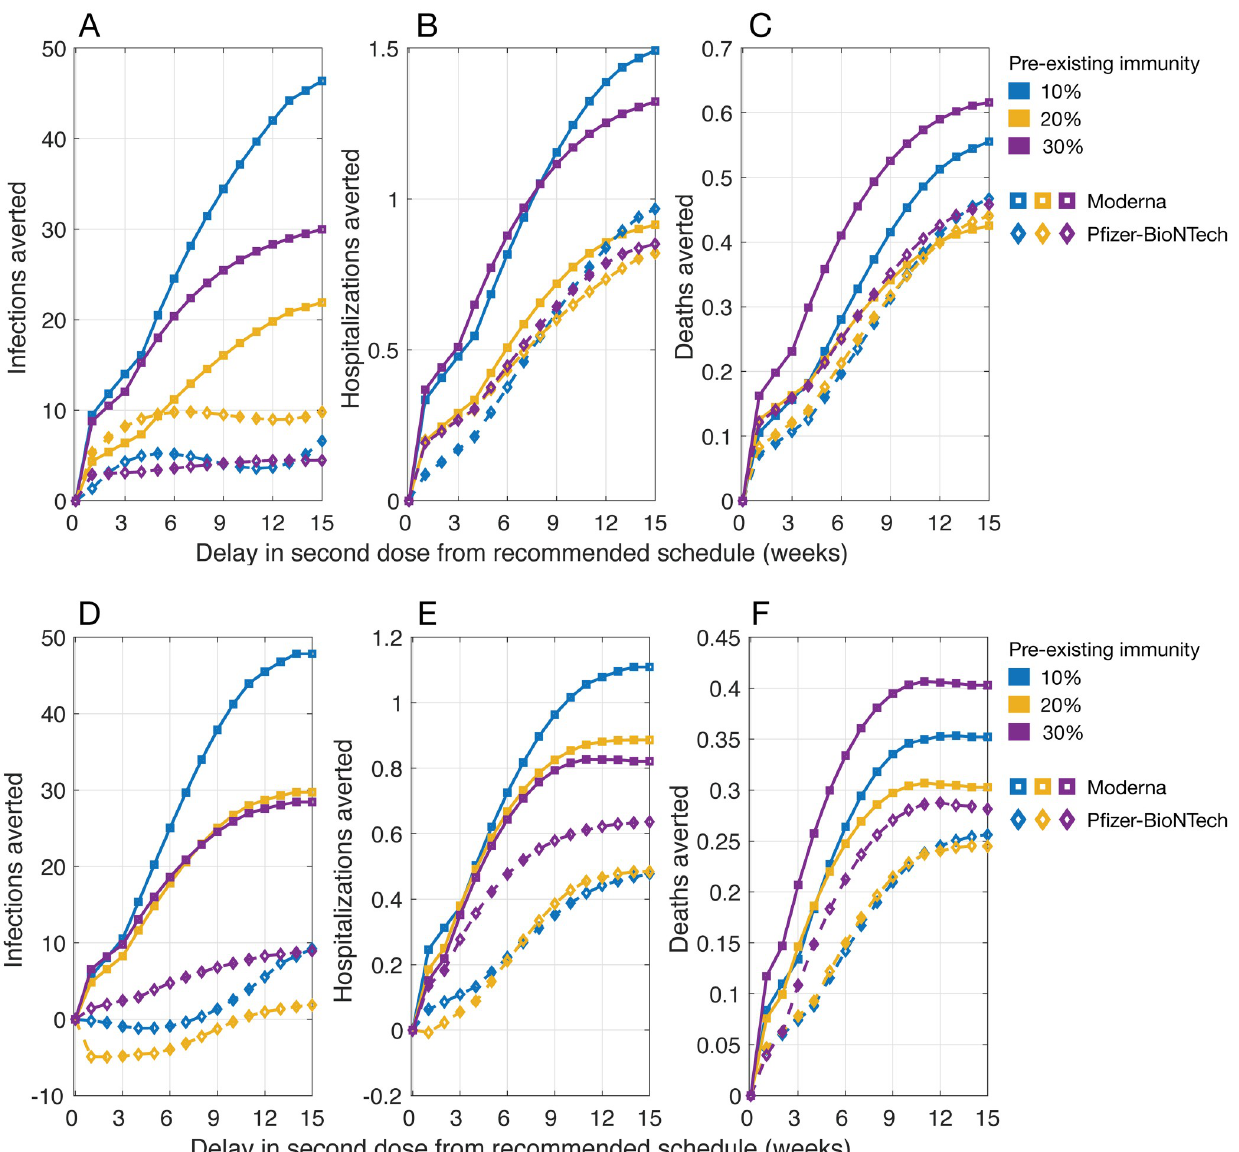
Fig 2. Projected number of infections, hospitalizations, and deaths averted per 10,000 population in a DSD vaccination program compared to the recommended schedule of 2 doses of Moderna (with a 28-day interval) and Pfizer-BioNTech (with a 21-day interval) vaccines. The daily vaccination rate was (A, B, and C) 30 doses and (D, E, and F) 45 doses per 10,000 population. Vaccine efficacy was set to the mean of estimated ranges (Fig 1) without waning of the first-dose efficacy prior to the administration of the second dose. The individual numerical values for A–C and D–F are listed in S1 and S2 Datas, respectively. DSD, delayed second